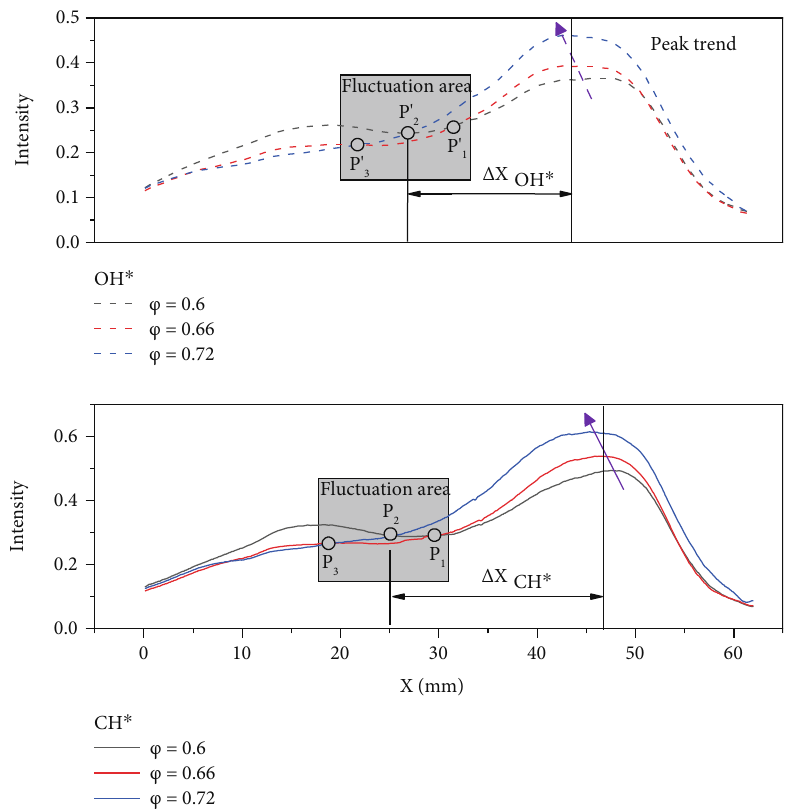
Figure 12: Distribution of chemiluminescence intensity along the axial